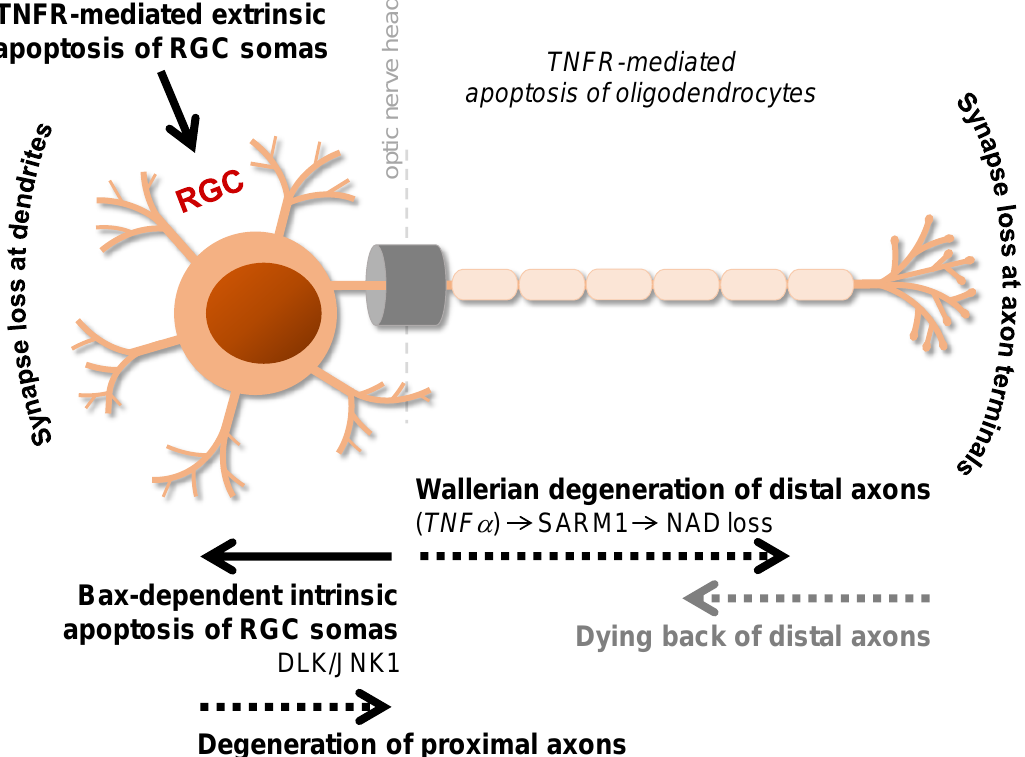
Figure 2. Distinct molecular programs regulate somatic and axonal degeneration of RGCs in glaucoma. Glaucomatous neurodegeneration involves RGC axons, somas, and synapses at dendrites and axon terminals. Optic nerve head is a critical site of injury, and early axonal insults may originate distal and proximal signals for axonal and somatic degeneration of RGCs. A distal axonopathy is processed through Wallerian degeneration and dying back, while degeneration of proximal axons is secondary to the apoptosis of RGC somas. The apoptotic death of RGCs is processed through intrinsic/mitochondrial and extrinsic/dead receptor-mediated